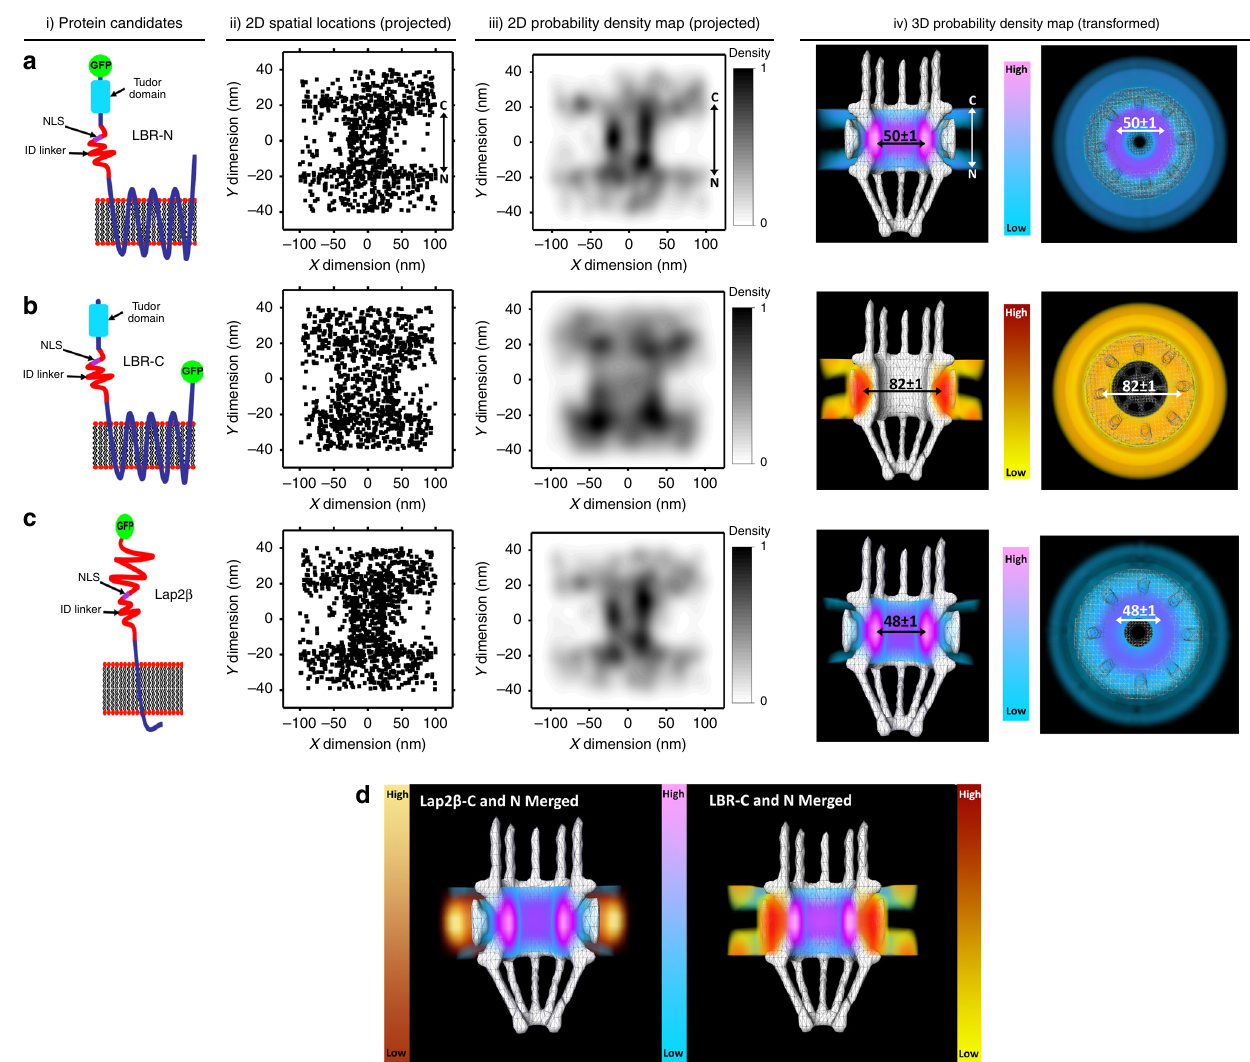
Fig. 2 Translocation routes of LBR and Lap2 β from the ONM to INM in live cells. a – c Transport routes of N-terminally tagged LBR (LBR-N), C-terminally tagged LBR (LBR-C), and N-terminally tagged Lap2 β (Lap2 β -N) respectively. (i) Schematic cartoon representation of each INM protein (orientation N- terminus to the left and C-terminus to the right). The depicted membrane represents a single bilayer of the NE. (ii) 2D spatial locations (projected) of each INM protein candidate. In the X dimension of the Cartesian graph, 0 represents the axial center of the NPC, and in the Y dimension, + 20 represents the ONM, and − 20 represents the INM. (iii) A normalized 2D probability density map showing the regions where the projected single-molecule localizations had the highest and lowest density. (iv) 3D probability density map generated by using the 2D to 3D transformation algorithm 52 , with regions of highest to lowest density (each color bar shows the gradient color change from high to low density). d Side by side comparison of the 3D probability density map of Lap2 β N and C terminus with LBR N and C terminus. Color bars indicate the regions of highest and lowest